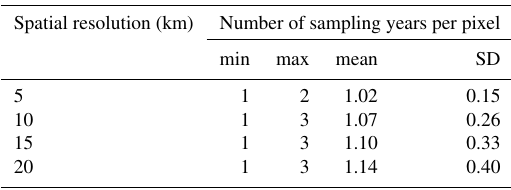
Table A4. Descriptive statistics of the number of sampling years per pixel, by pixel spatial resolution (km): min is minimum, max is maximum, mean is average, and SD is standard